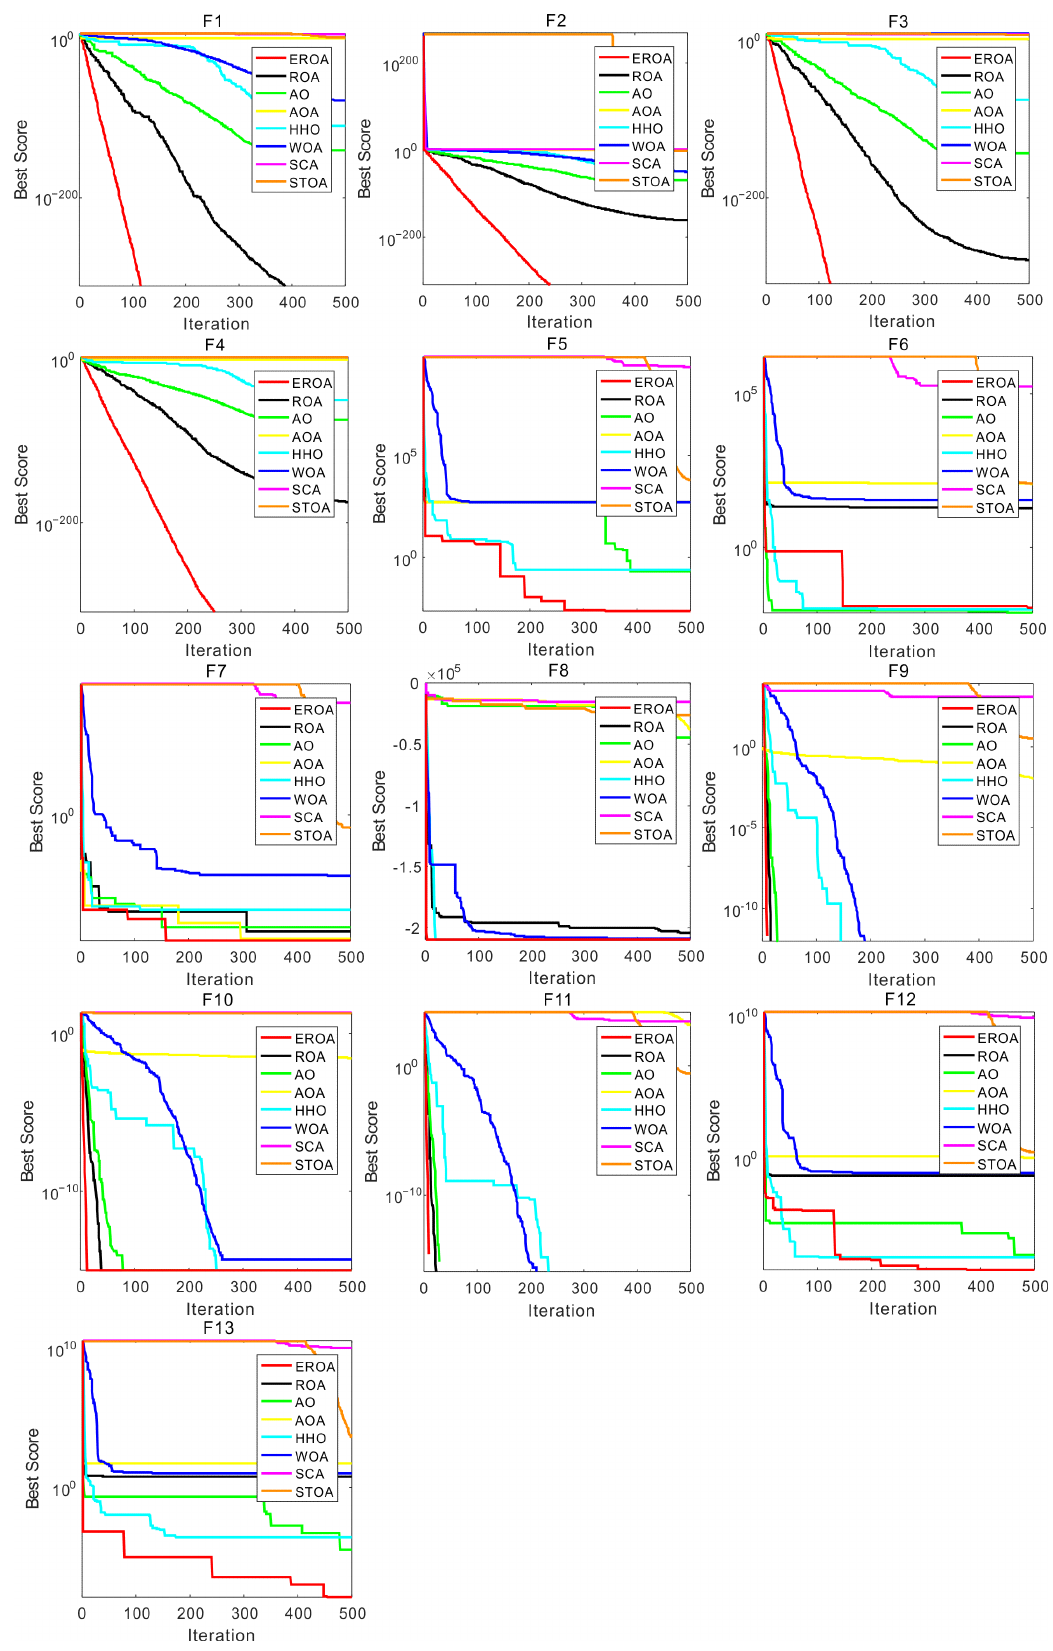
Figure 5. Convergence curves for the optimization algorithms for standard benchmark functions with D = 500.